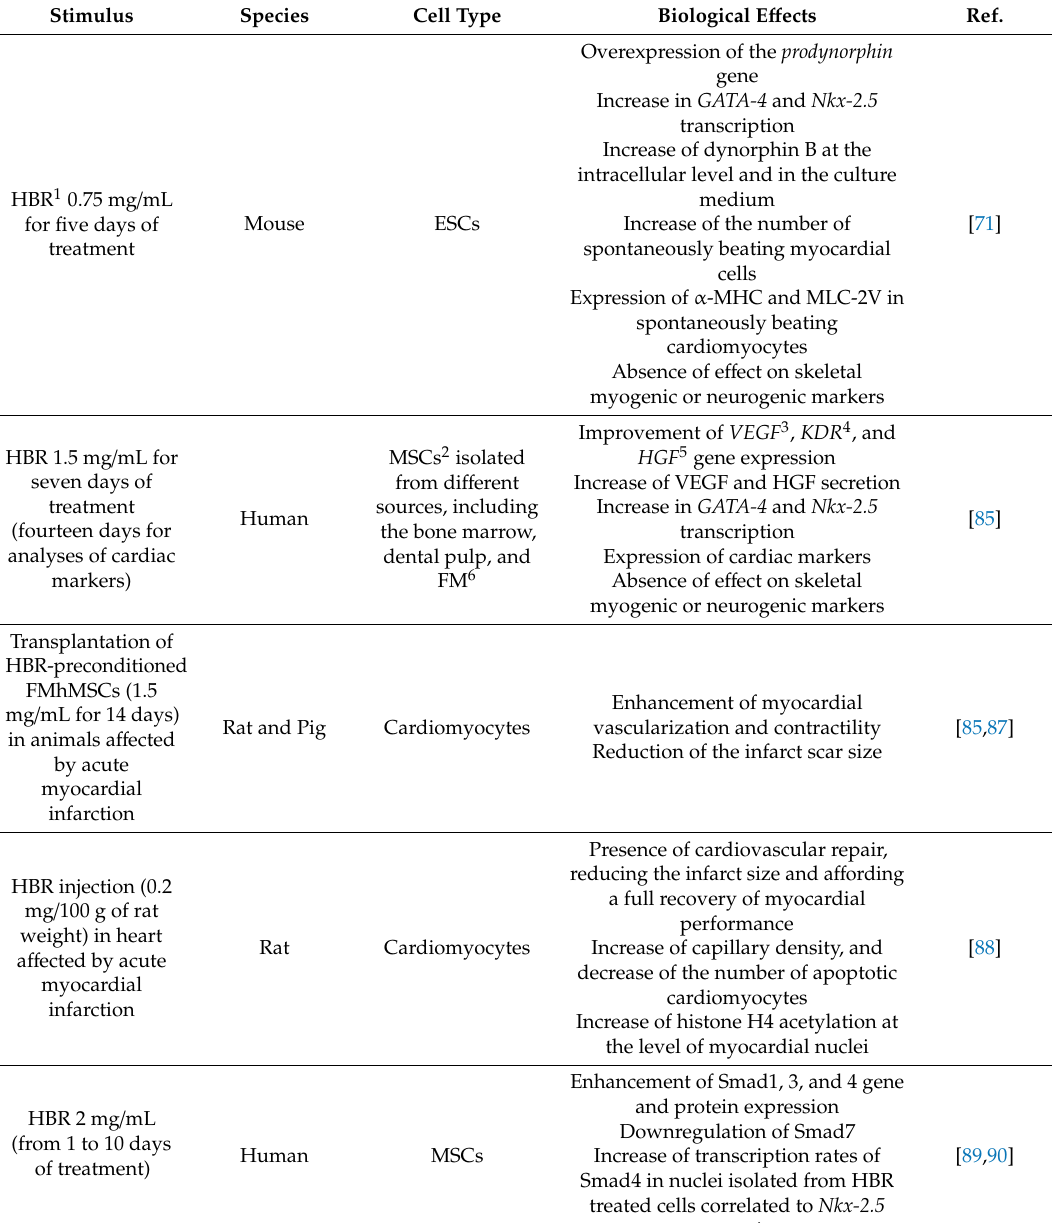
Table 2. Hyaluronan mixed esters of butyric and retinoic acids (HBR) studies for cardiac commitment and